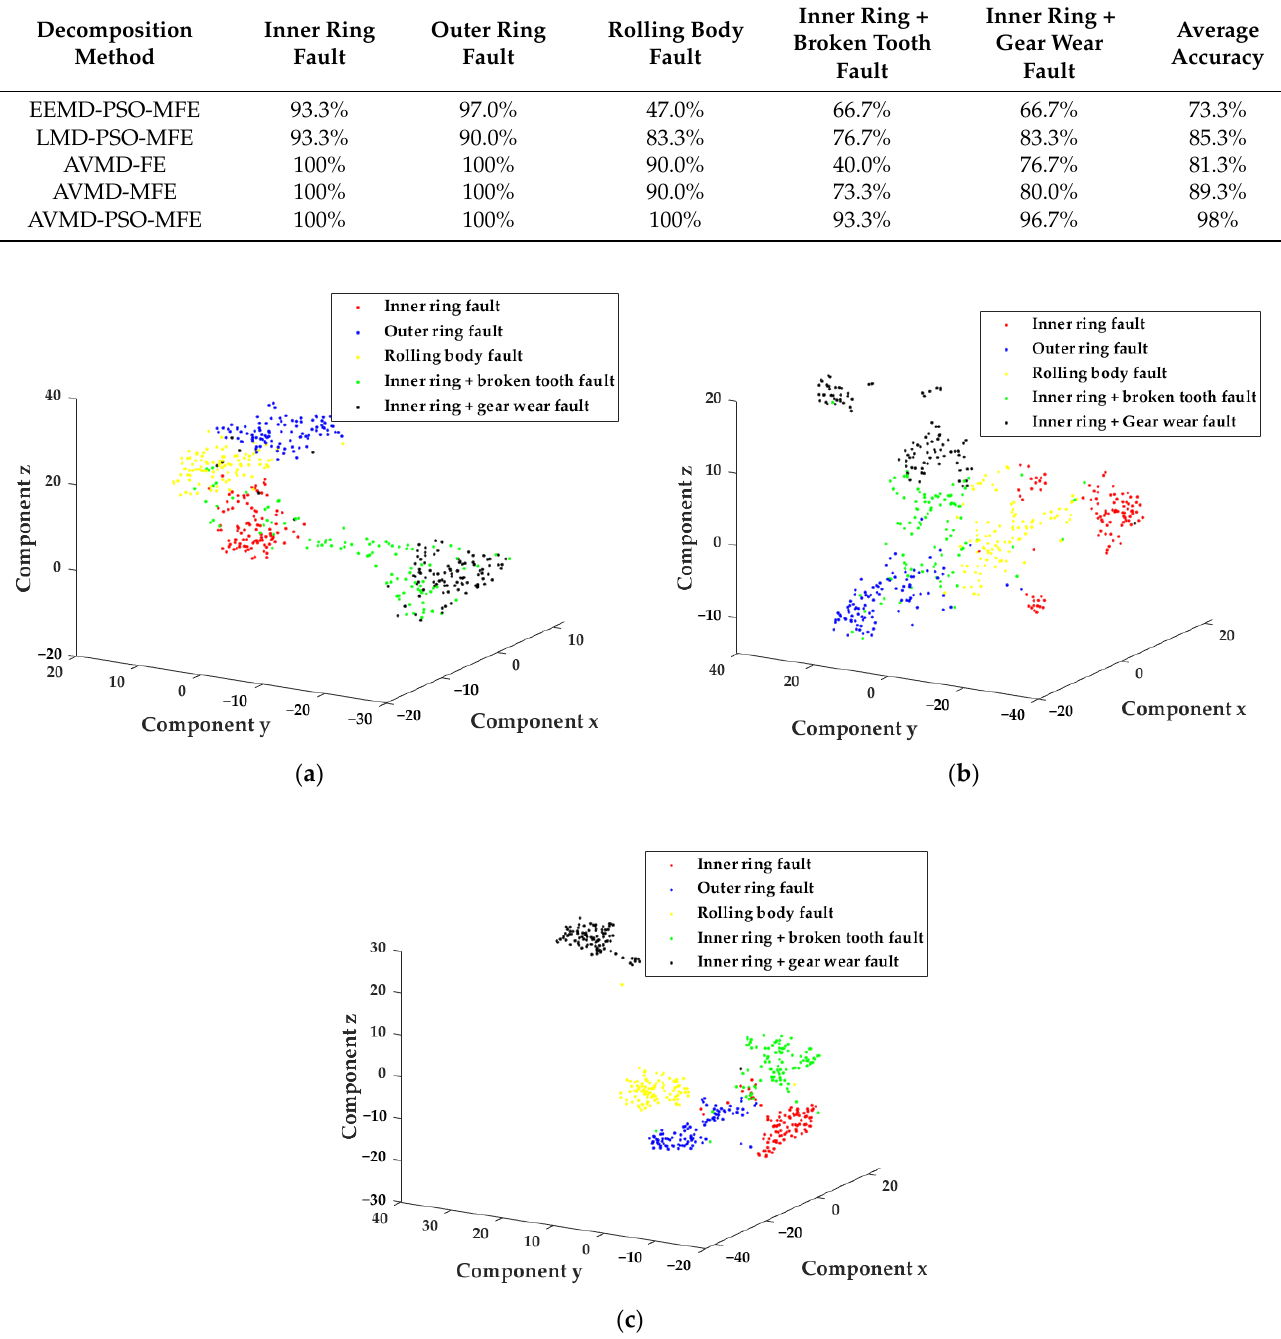
Table 6. Accuracy of different fault features.